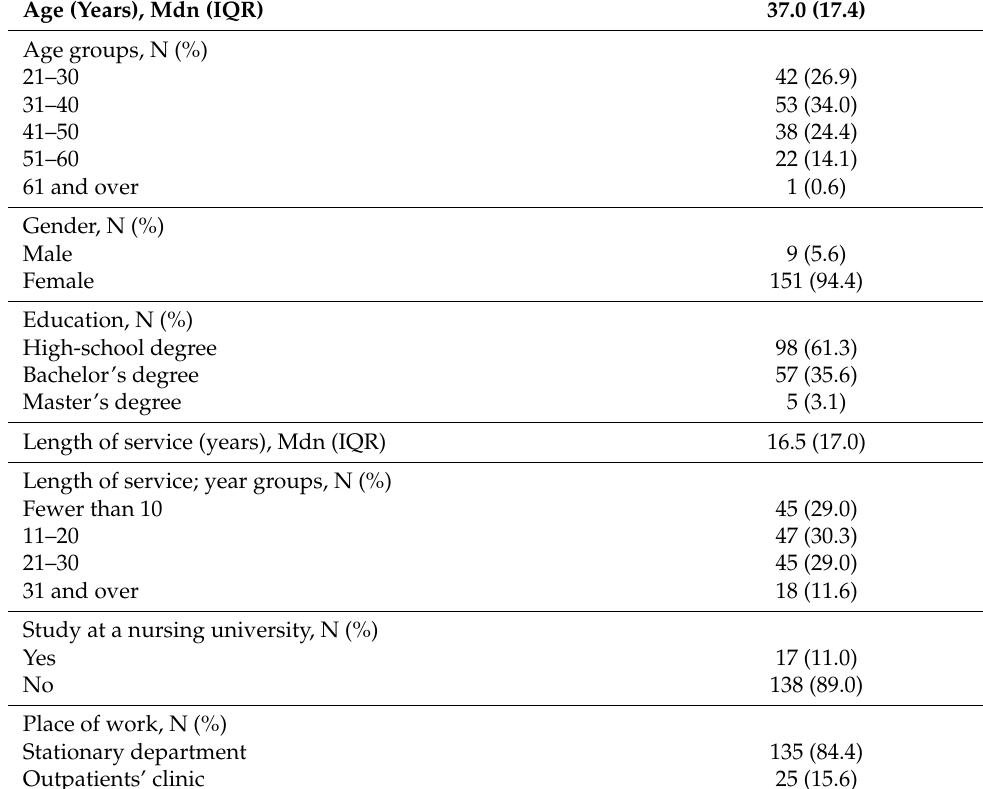
Table 1. Nurses’ sociodemographic characteristics and levels of knowledge about basic human needs (N =